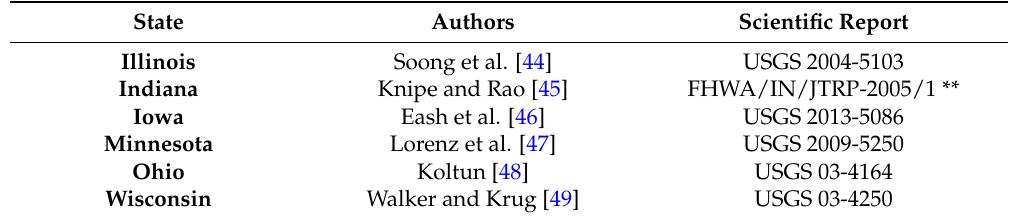
Table 1. Publications with discharge versus recurrence interval data for the 150 rivers evaluated.